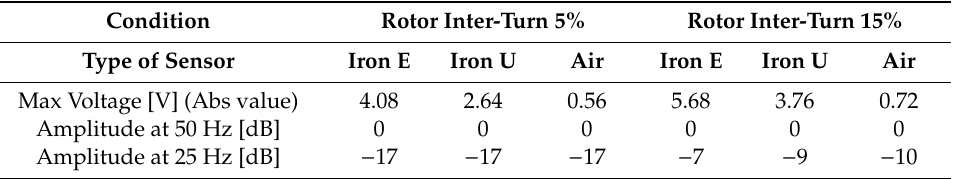
Table 3. Results of rotor inter-turn